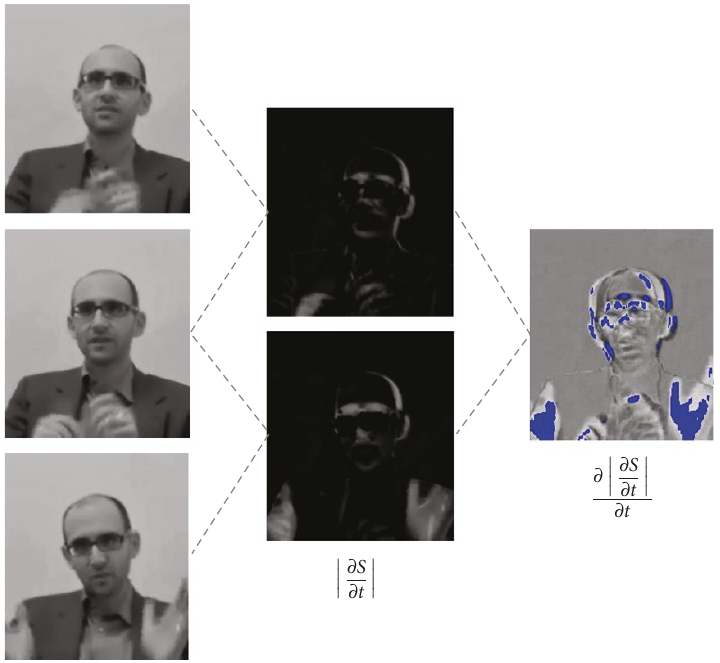
Figure 4: Vertical movement